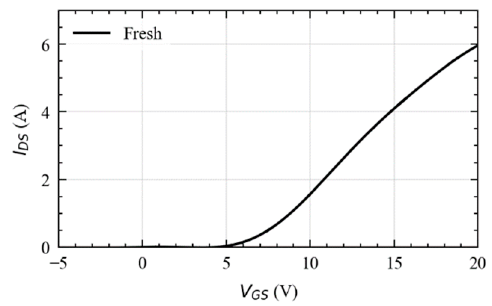
Figure 4. Fresh I DS - V GS characteristics for tested silicon carbide (SiC) MOSFET obtained with ( V GL ; V GH ) = ( − 5 V; 20 V) and V PL = 3 V.